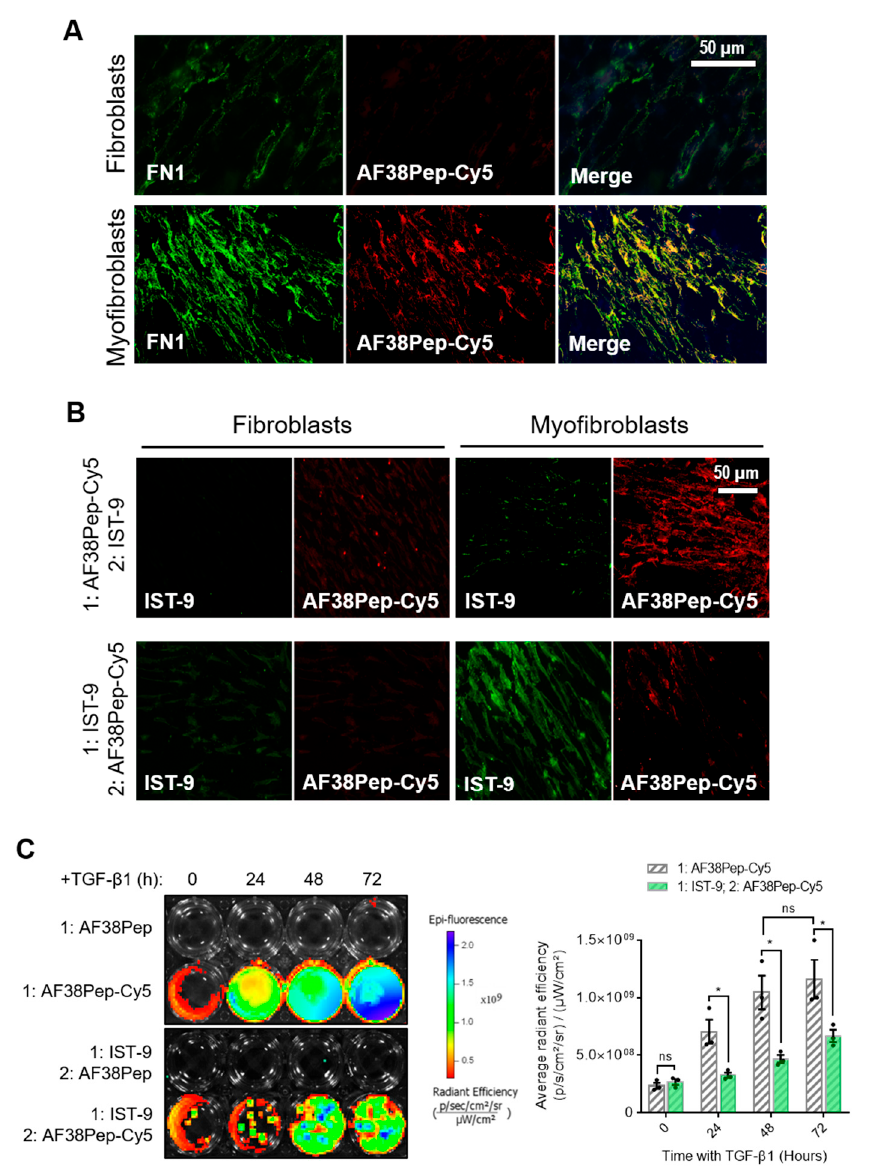
AF38Pep or TGF- β 1+AF38Pep treatments. Data are representative of three independent experi- ments and displayed as the mean ± S.E. Statistical analysis is shown as *** p ≤ 0.001, * p ≤ 0.05, and ns = no statistical significance ( p > 0.05).